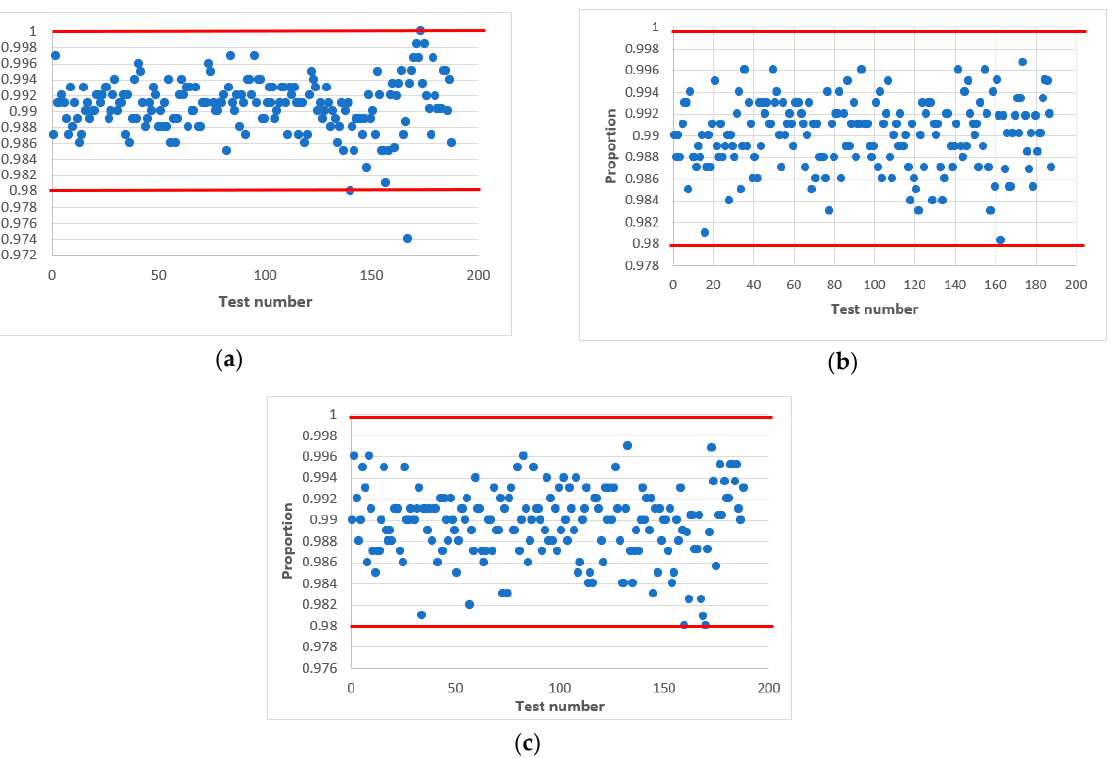
Figure 8. Statistical portrait of the MAFG output sequence for h = 8, a = a 0 ⊕ a 2 with initial = .